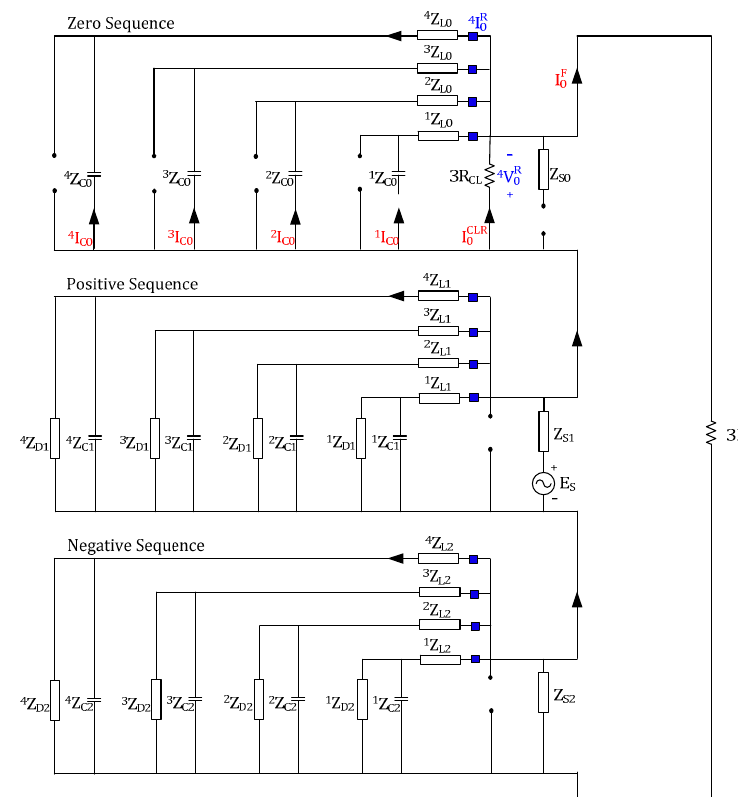
Figure 4. Interconnections in the case of an SLG fault in a 22 kV busbar.